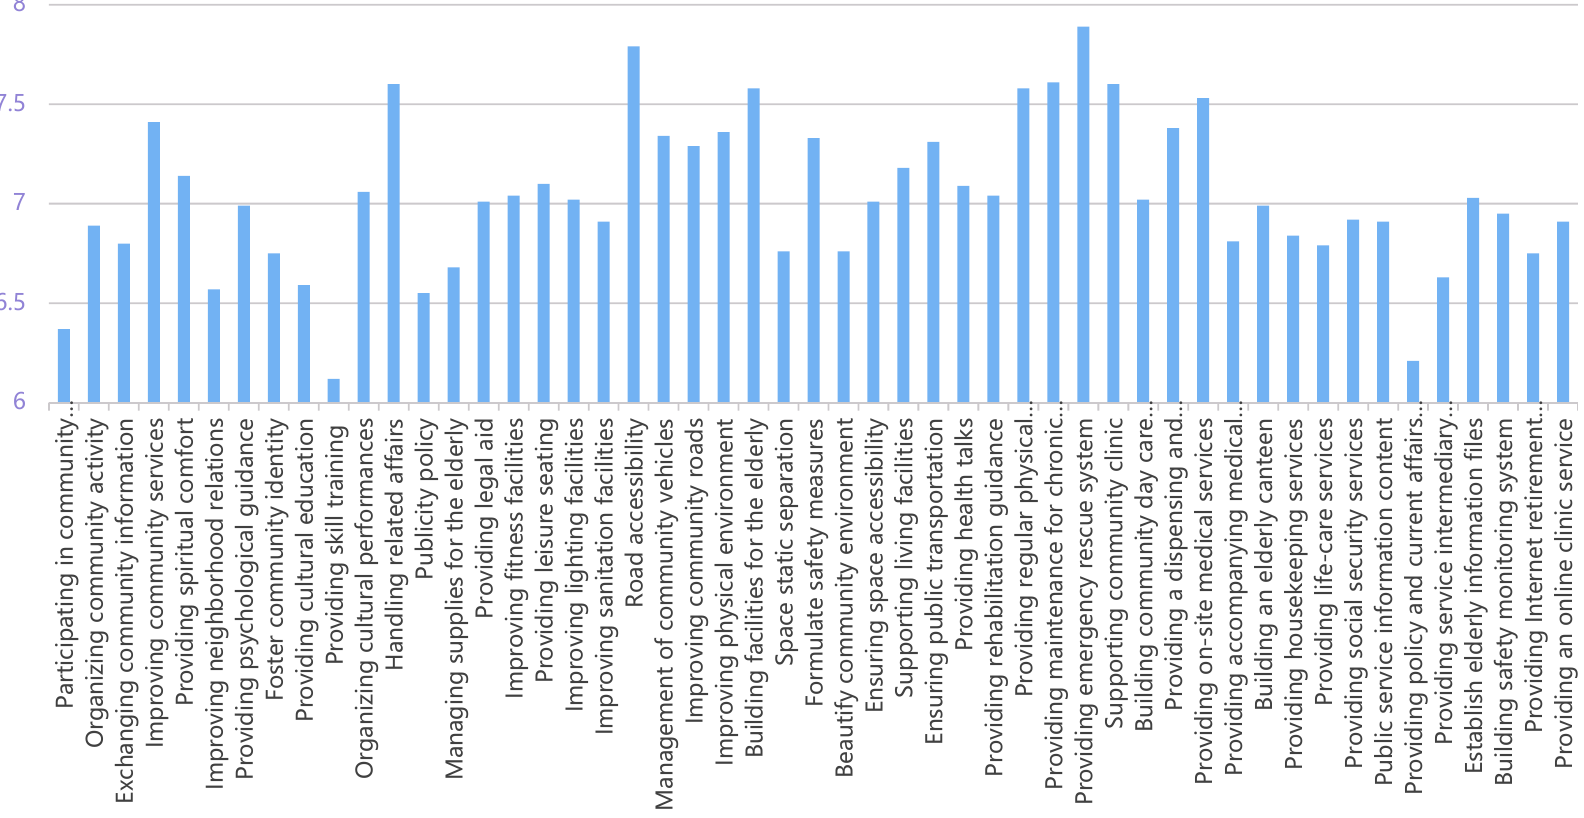
Figure 1. Steep slope analysis diagram.